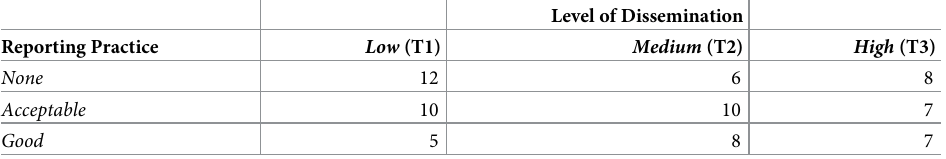
Table 6. Distribution of studies according to their reporting practice and level of dissemination.